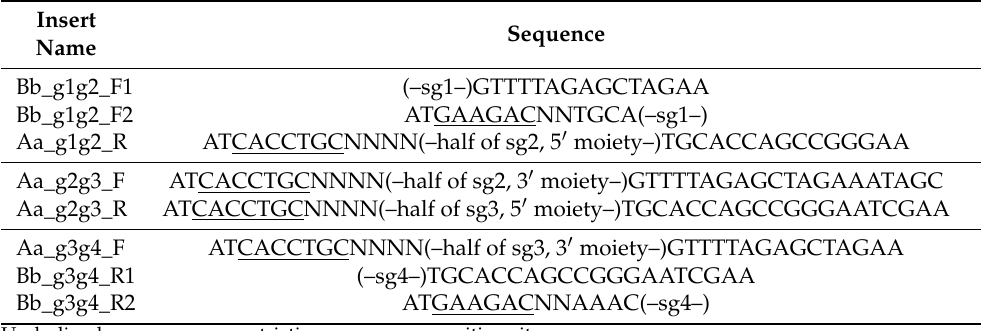
Table 2. List of primers and sequences for the pBAtC_4sg insert.